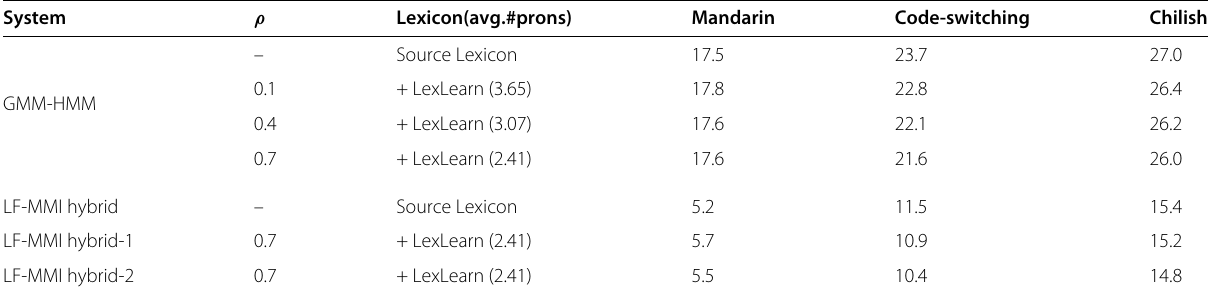
Table 4 Performance(TER%) comparison of the proposed lexicon learning-based pronunciation augmentation on conventional ASR systems System ρ